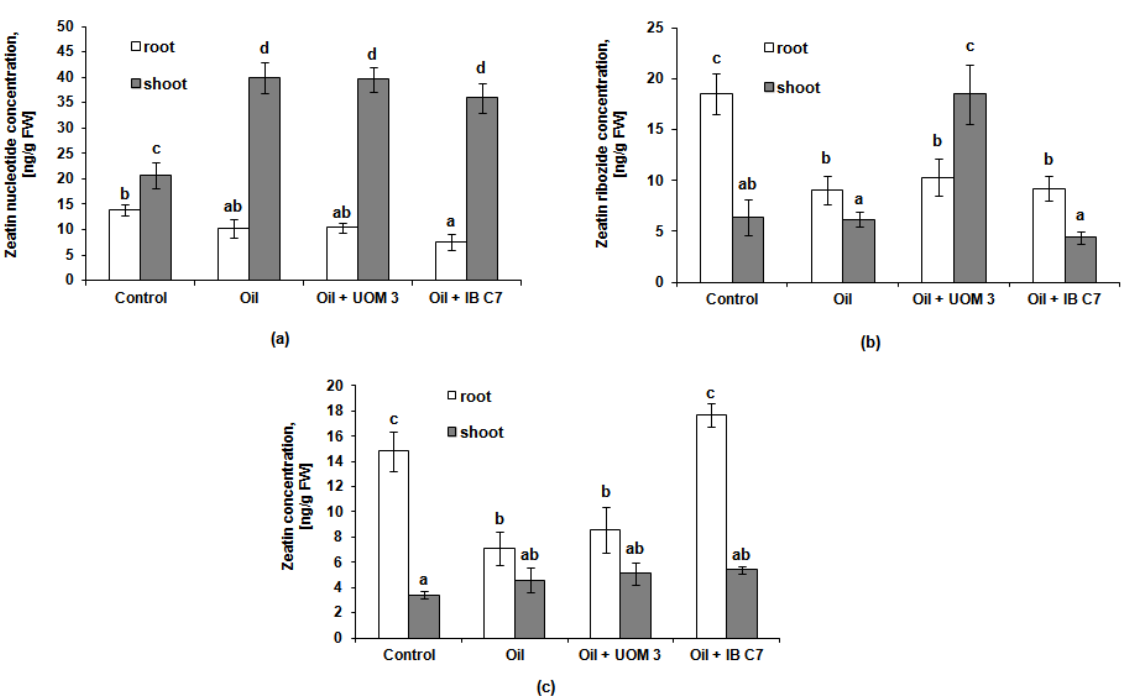
Figure 5. Zeatin nucleotide ( a ), zeatin ribozide ( b ), zeatin ( c ) content in roots and shoots of barley plants. UOM 3 and IB C7, variants of experiments with introduction of Enterobacter sp. UOM 3 and P. hunanensis IB C7, respectively. Statistically different means values for each indicator ( n = 9) are marked with different letters ( p ≤ 0.05).